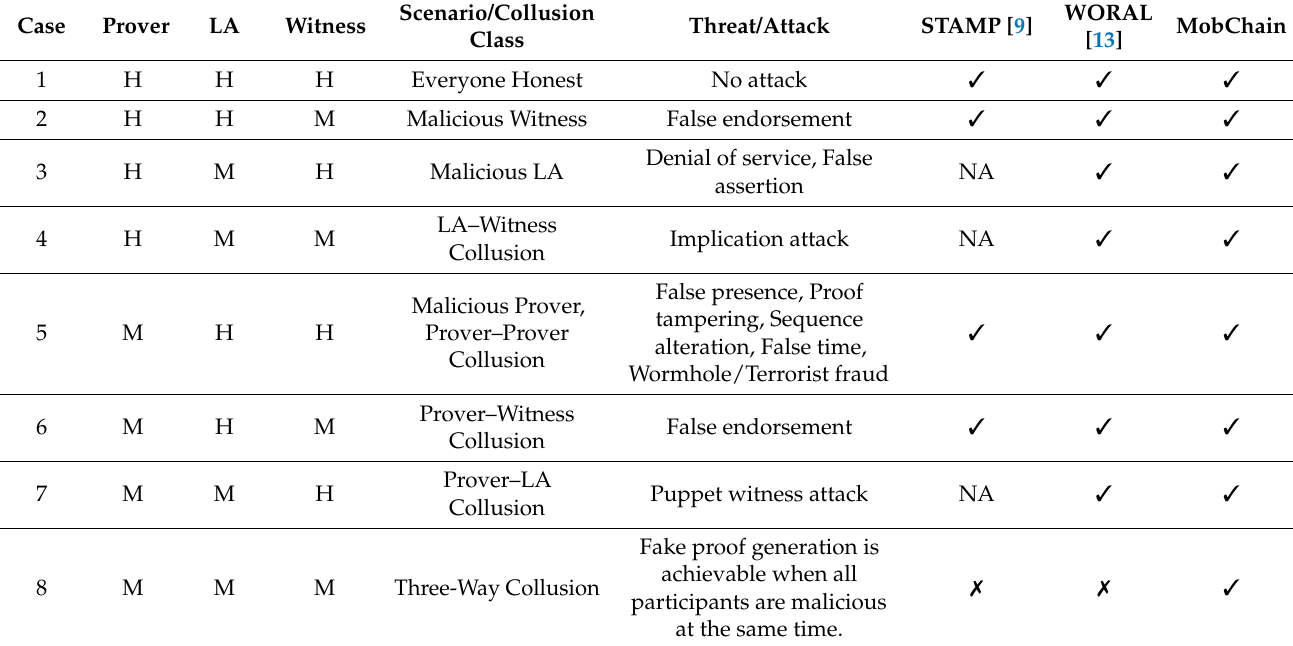
Table 2. Malicious participants and possible collusion